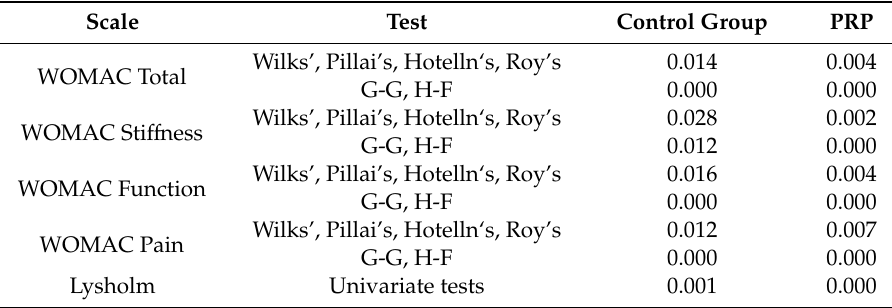
Table 2. Results of RM ANOVA statistical